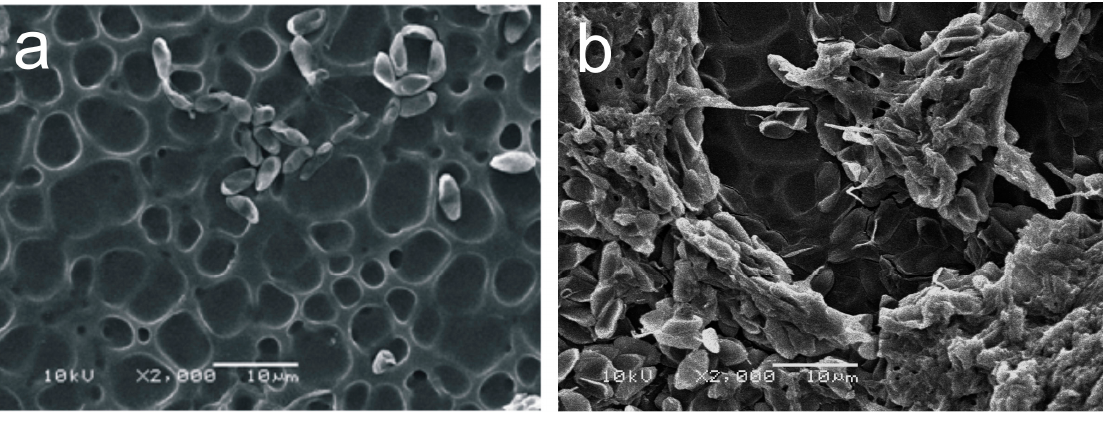
Figure 4. SEM Images of PU films incubated for 60 days in the presence of entomopathogenic fungus Metarhiziumanisopliae : ( a ) untreated film; and ( b ) UV treated film in an oxygen atmosphere for 120 min.